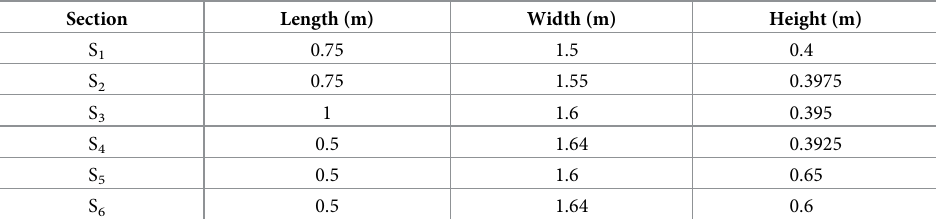
Table 7. Vehicle modeling—Citroe¨n C-15.